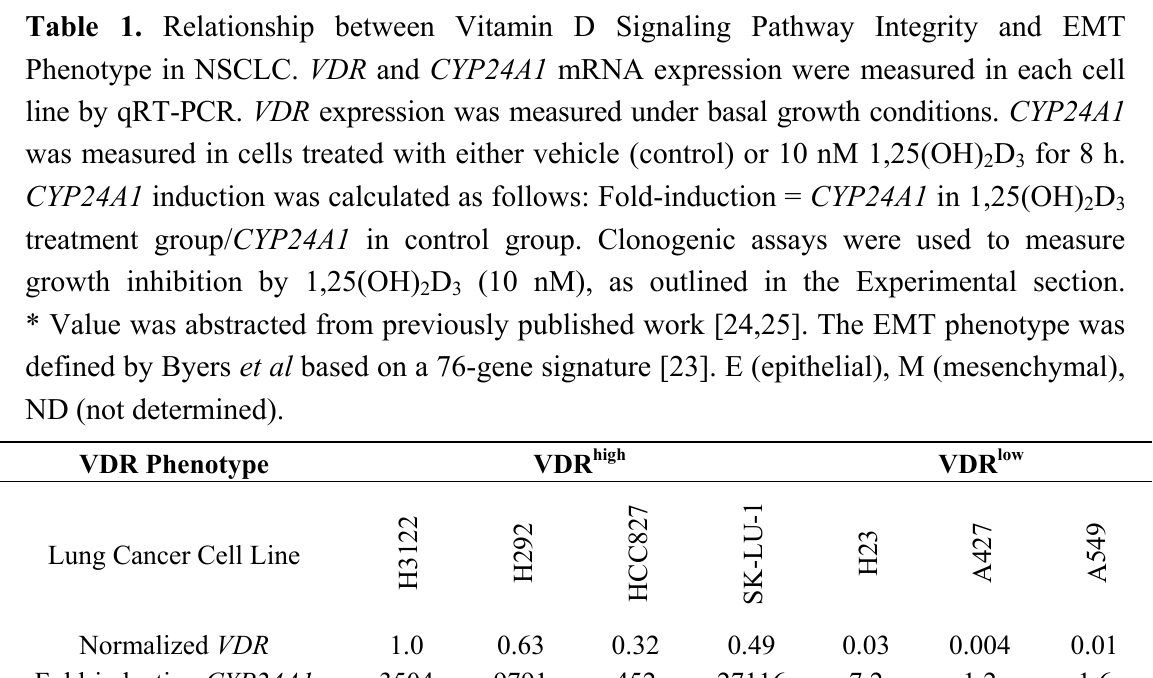
Table 1. Relationship between Vitamin D Signaling Pathway Integrity and EMT Phenotype in NSCLC. VDR and CYP24A1 mRNA expression were measured in each